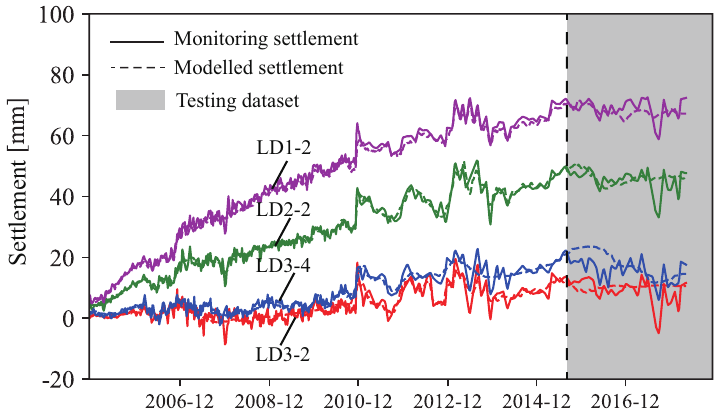
Figure 11. Fitting and prediction results of PL1-2, PL2-2, PL3-2, and